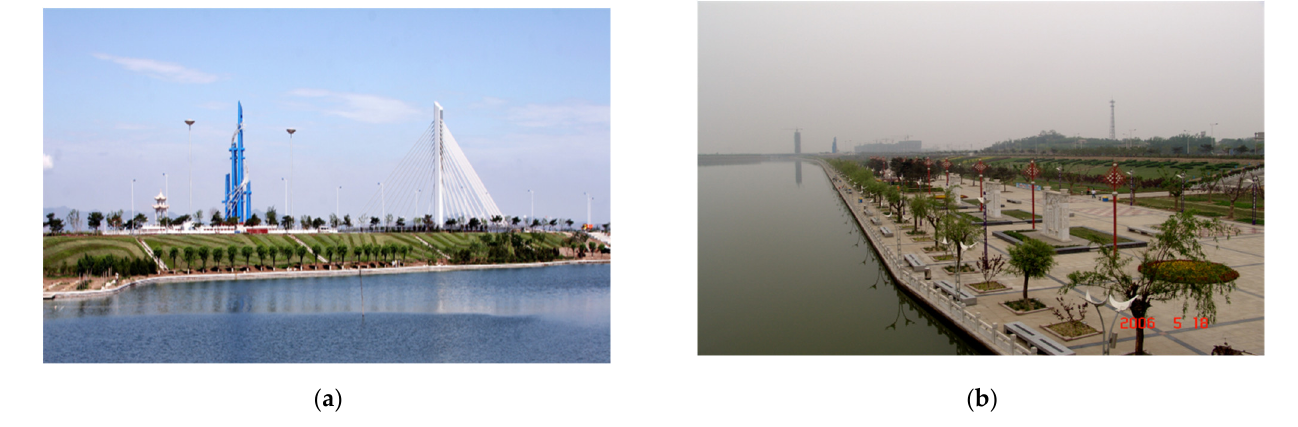
Figure 17. Scenic area of the riverfront landscape. ( a ) Cultural landscape. ( b ) Riverside park.